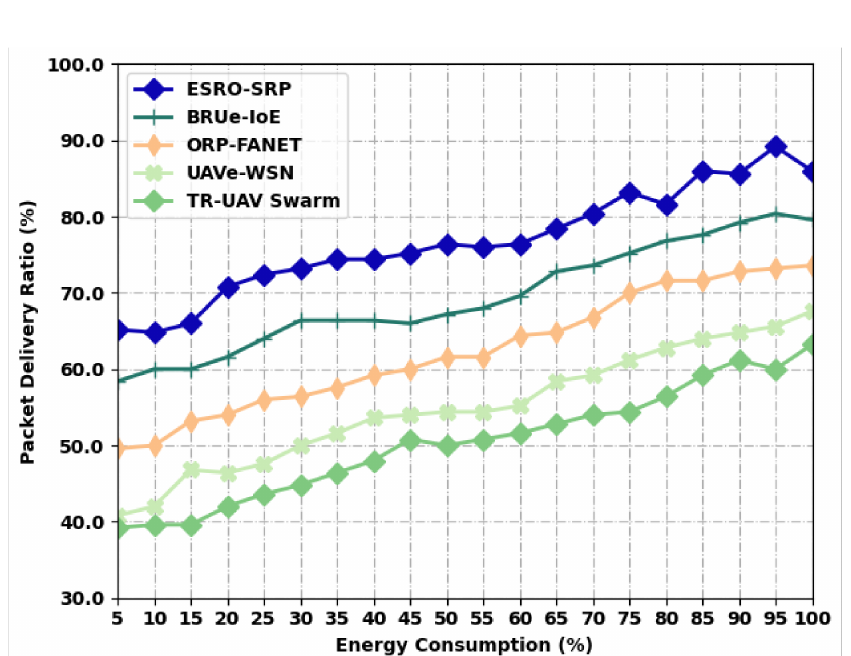
Figure 3. PDR analysis of ESRO-SRP technique under distinct levels of